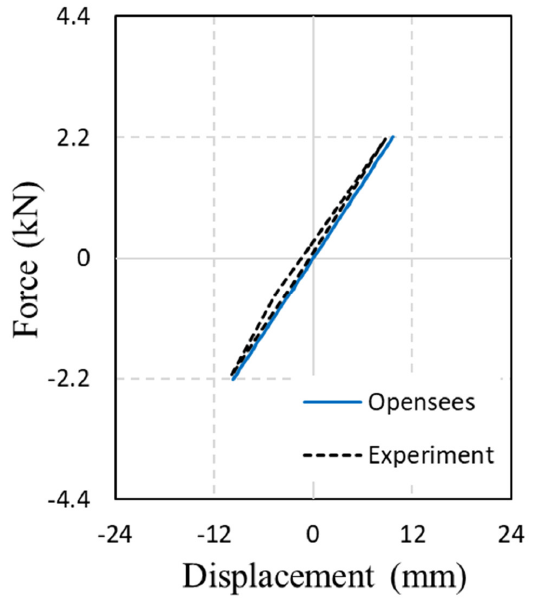
Figure 13. Numerical and experimental results (first cycle).